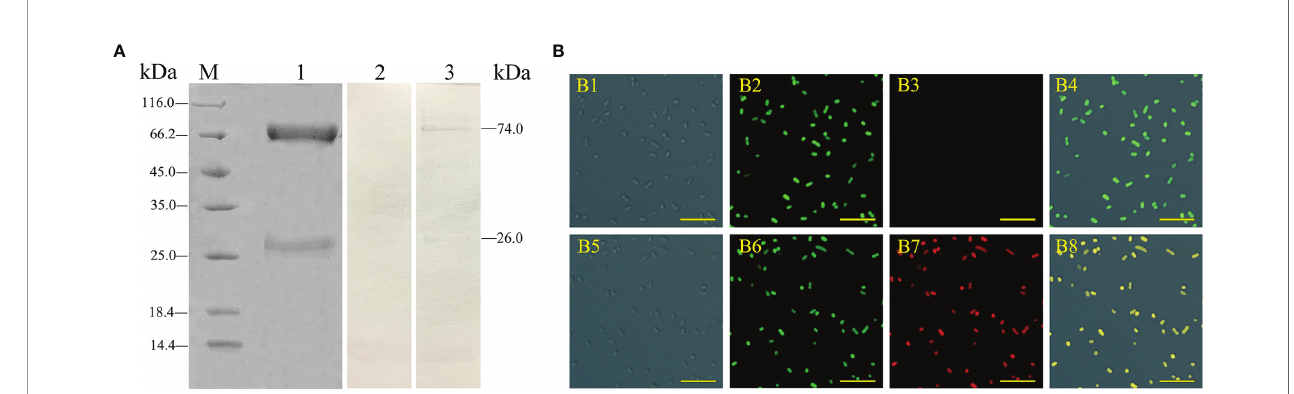
FIGURE 1 | Analysis of the characteristics of rabbit anti-IgM serum and fl ounder antisera. (A) Flounder serum IgM and rabbit anti-IgM sera were analyzed by SDS- PAGE and western blotting. Lane M, molecular mass marker; Lane 1, puri fi ed fl ounder sera IgM; Lane 2, negative control using the serum of unimmunized rabbit; Lane 3, fl ounder sera IgM was immunostained by anti-IgM polyclonal antibodies. (B) Analysis of the binding activity of fl ounder anti- E. tarda serum. B1 and B5: E . tarda was observed under differential interference microscope. B2: FITC labeled E . tarda . B6: Immuno fl uorescence-stained bacteria with fl ounder antiserum, anti-IgM mAb and Alexa Fluor ® 649 goat anti-mouse IgG (B7), and healthy fl ounder sera were used as control (B3). B4 and B8: Merge images of each fl uorescent channel (Bar = 10 m m).